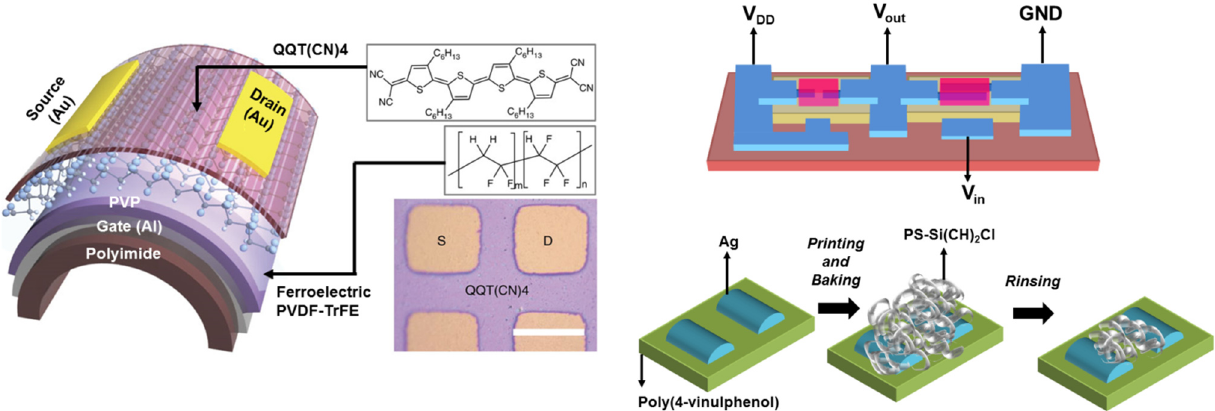
Figure 2. ( a ) Schematic representation of the devices and molecular structure of the organic semiconductor quinoidal oligothiophene derivative (QQT(CN)4) and the ferroelectric polyvinilidene-co-trifluoroethylene (PVDF-TrFE). Reprinted by permission from Macmillan Publishers Ltd.: Nature Communications [13], copyright (2014); ( b ) schematic of an all-inkjet-printed inverter using two p-type OTFTs (top) and diagrams of the PS brush treatment procedure on the PVP gate dielectric and Ag S/D electrodes (bottom). Reprinted with permission from [21]. Copyright © 2013 WILEY-VCH Verlag GmbH & Co. KGaA, Weinheim,